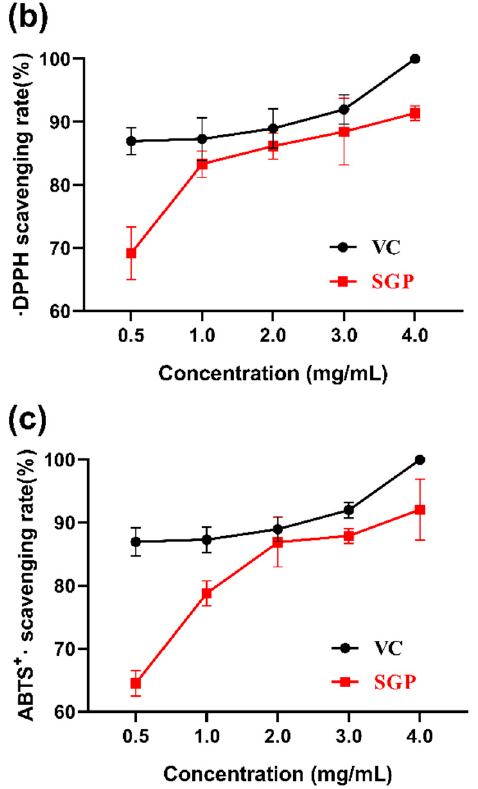
Figure 4. In vitro free-radical-scavenging abilities of SGP-1-1. ( a ) DPPH · -scavenging ability of SGP-1-1; ( b ) · OH-scavenging ability of SGP-1-1; ( c ) ABTS + · -scavenging ability of SGP-1-1.